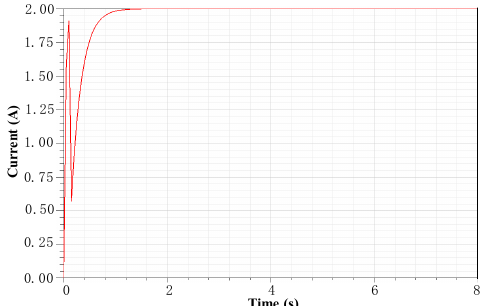
Figure 8. Influence of coil inductance on current–time characteristics of electromagnet.